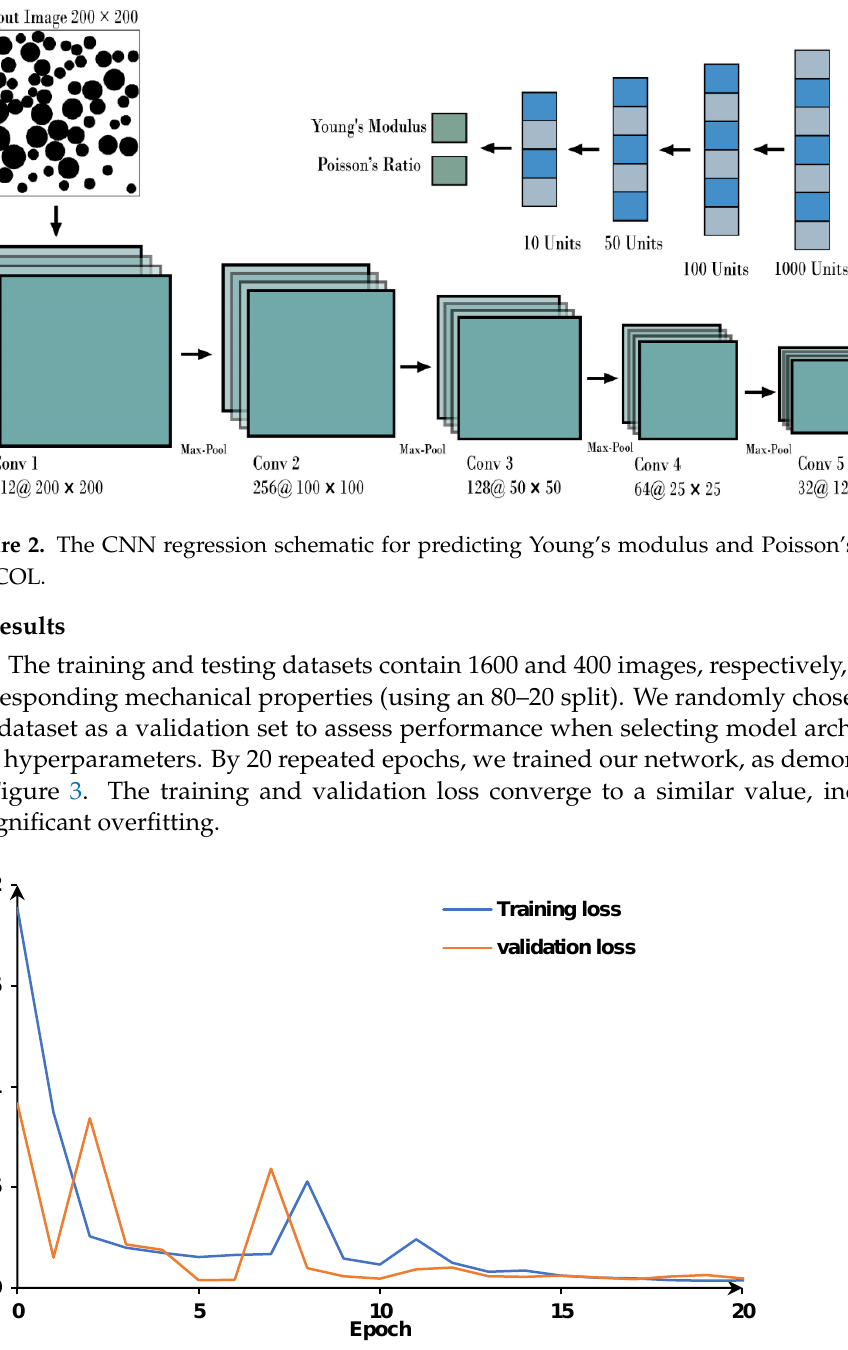
Figure 3. Training and validation loss over 20 epochs display convergence and behavior of model training.